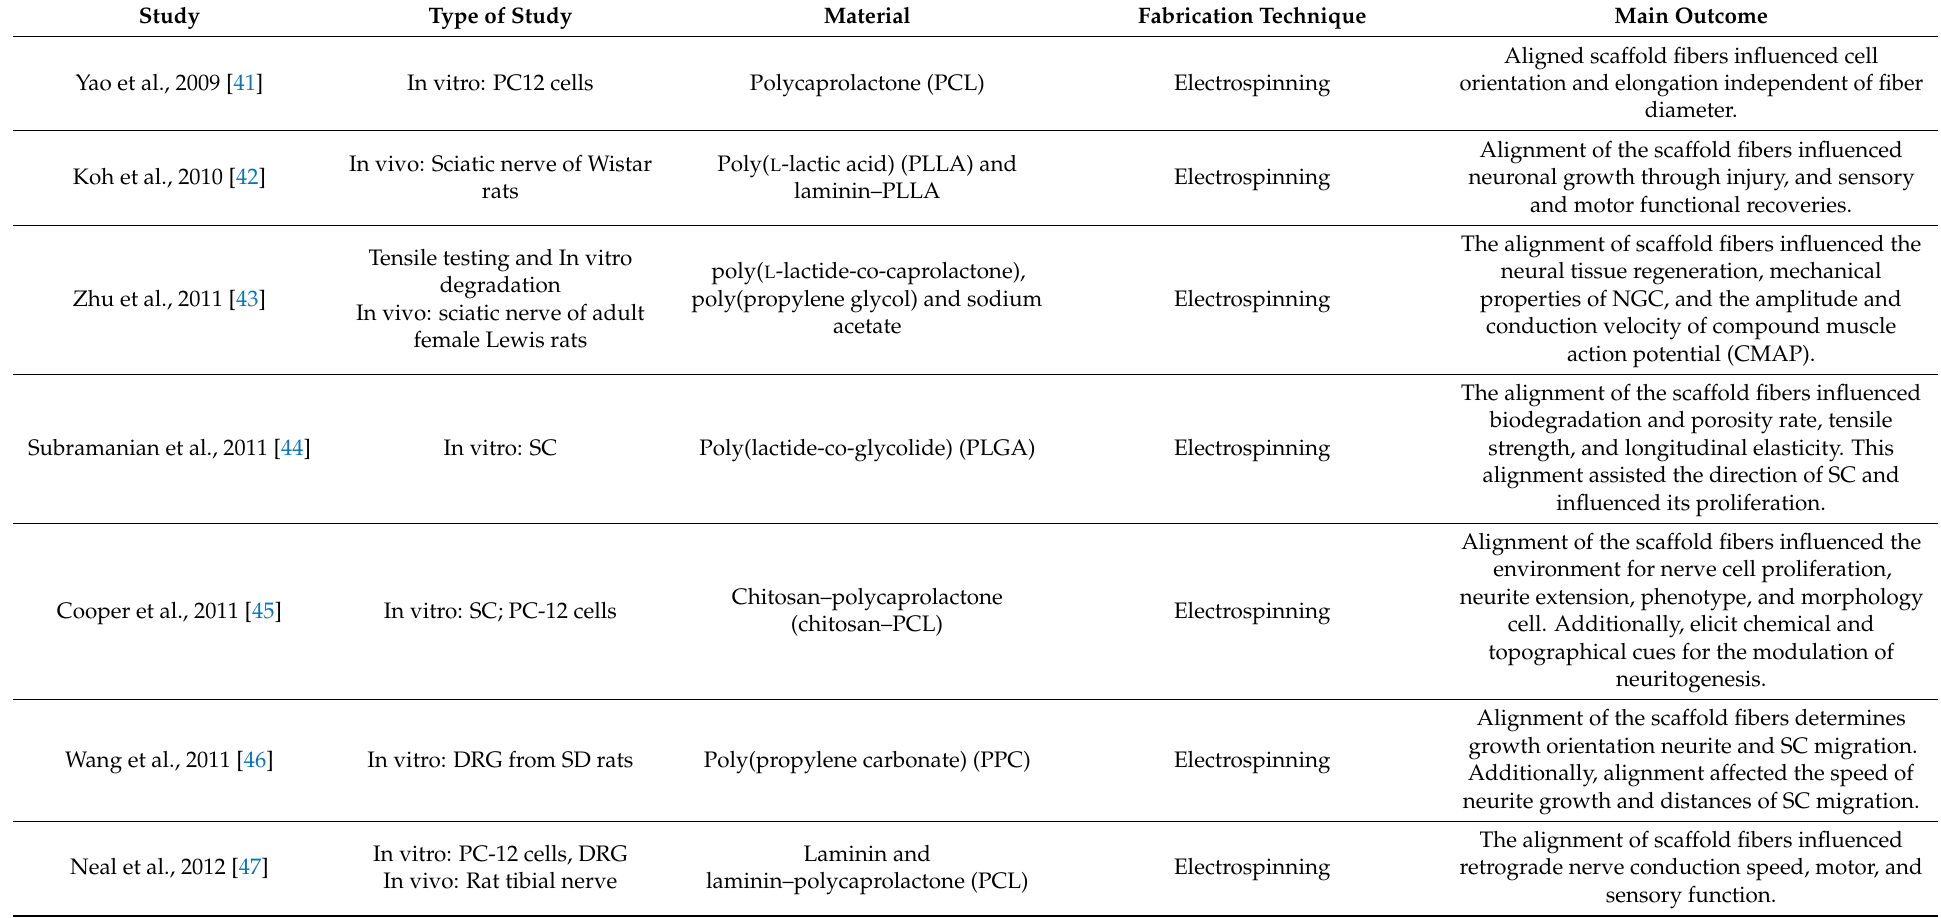
Table 5. Studies evaluating alignment of the NGC polymeric